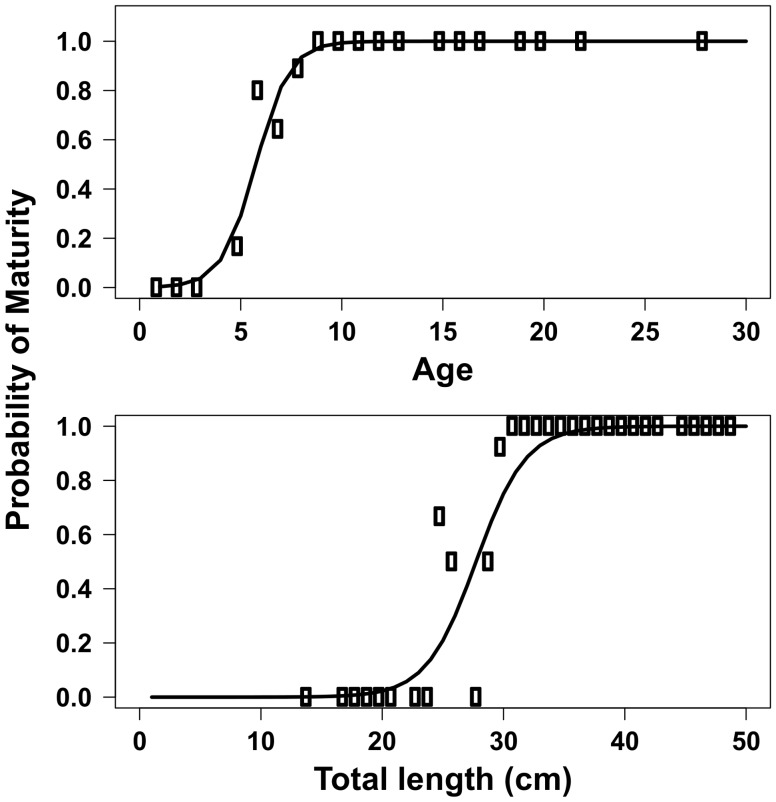
Probability of reproductive maturity for grass rockfish (Sebastes rastrelliger) in the Santa Barbara Channel, CA, USA.A) Probability of maturity at age, B) probability of maturity at length. Solid line represents the maximum likelihood fit to the data. .